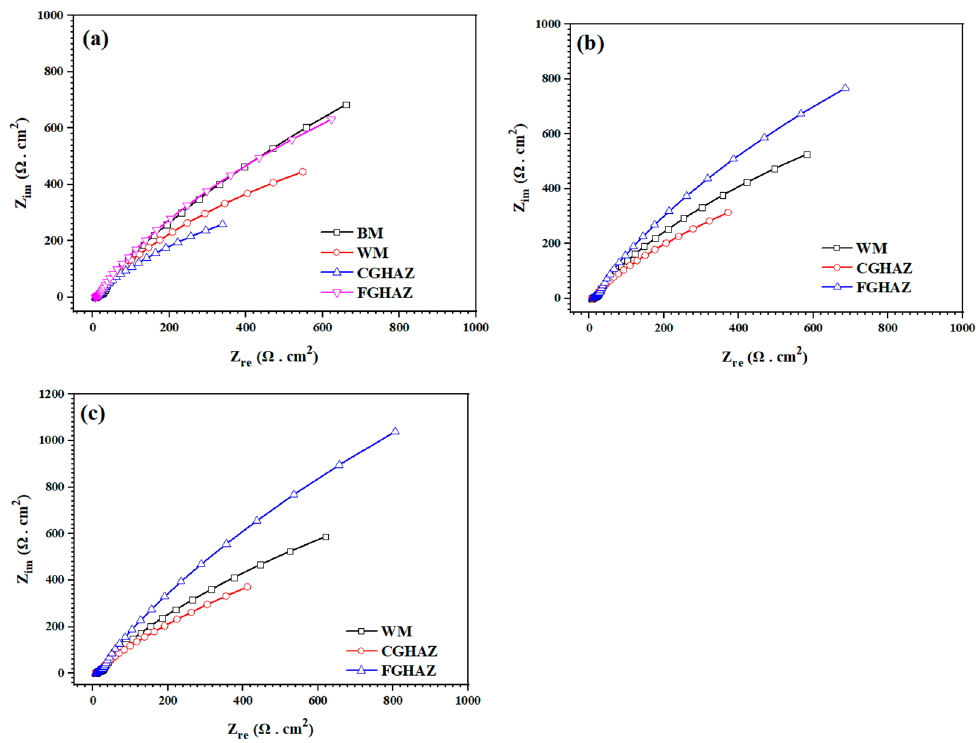
Figure 14. EIS results for 96 h immersion of BM and different zones in laser welded joints in NACEA solution with saturated H 2 S at 50 °C : ( a ) 2.86; ( b ) 4 and ( c ) 6.67 kJ/cm.